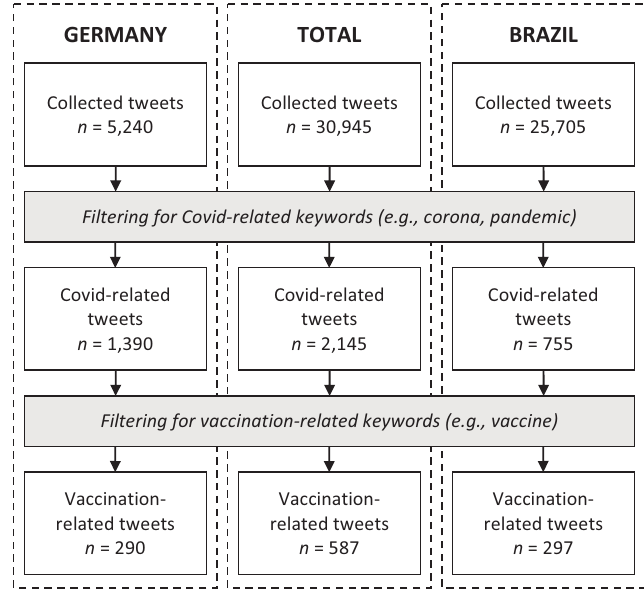
Figure 2. Filtering steps for the German and Brazilian data